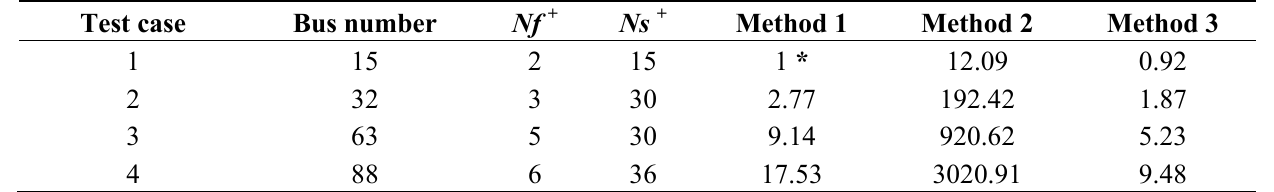
Table 8. Performance comparisons.